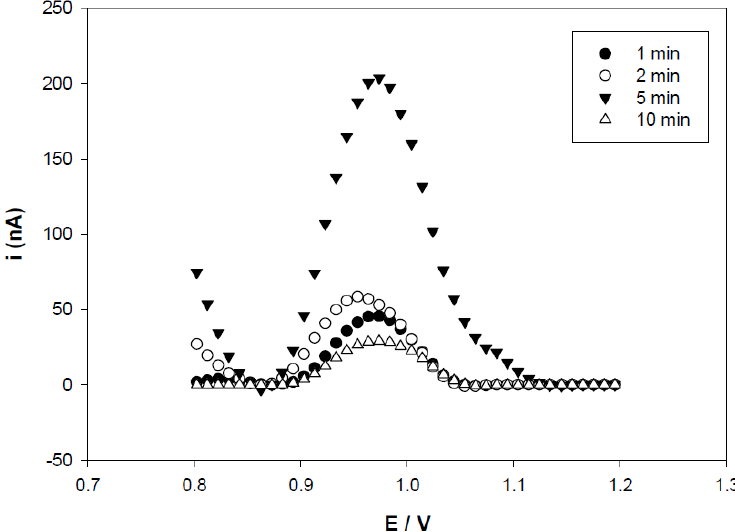
Figure 3 . The differential pulse voltammograms of guanine oxidation at TSF-1P (1 µM) immobilized activated for different times (●) 1 min, (○) 2 min, (▼) 5 min and (∆) 10 min. Voltammetric conditions: scanning potential steps, 20 mV/s; potential amplitude, 50 mV.